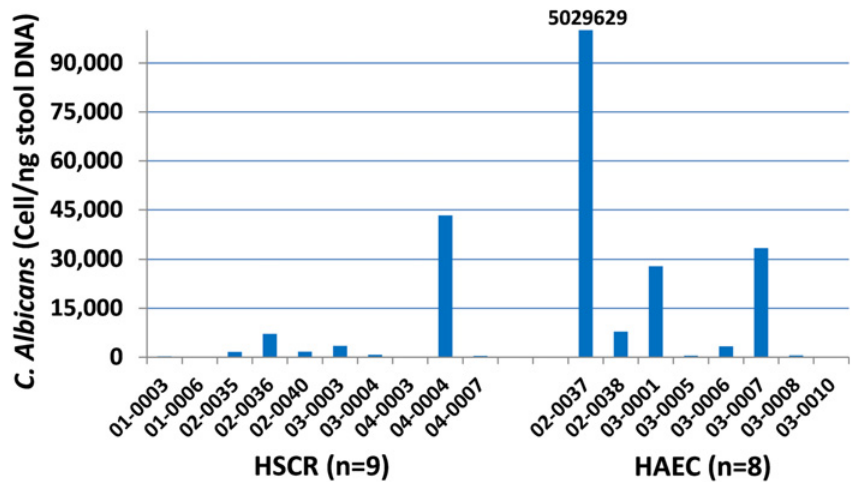
Fig 3. Quantitative PCR of Candida albicans . The quantitation of C . albicans by quantitative PCR on total fecal DNA from HSCR and HAEC patients.